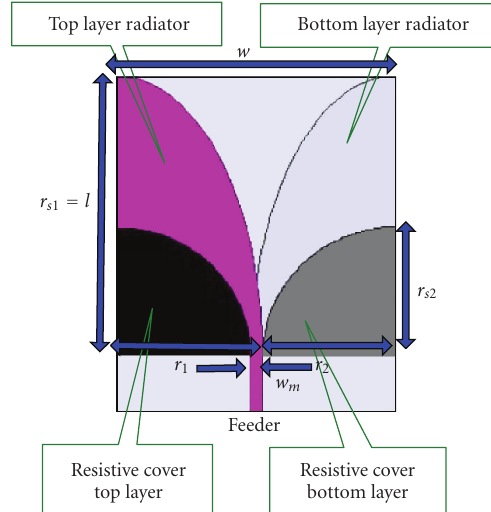
Figure 1: Configuration of the proposed